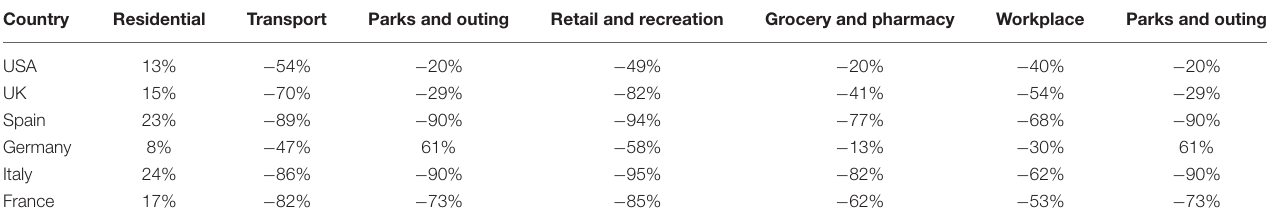
TABLE 2 | Mobility index report based on Google tracking. Country